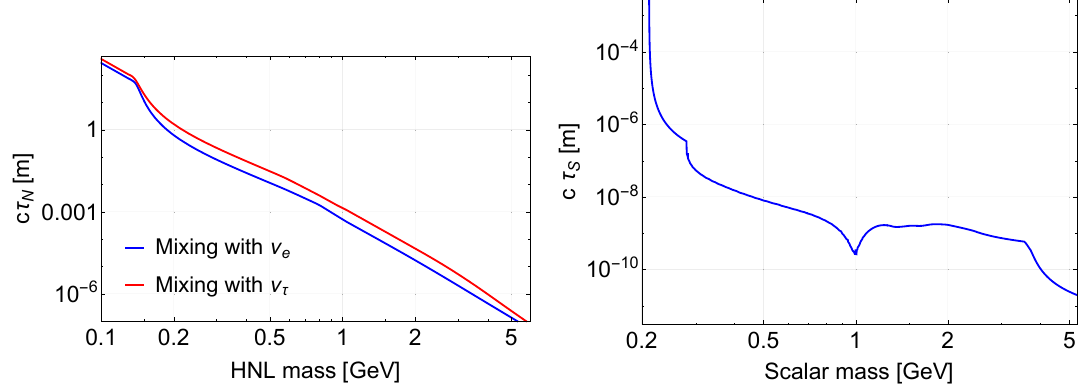
Figure 16 . The dependence of the proper lifetime cτ on the mass for the HNL (left panel, based on [24]) and the scalar (right panel, based on